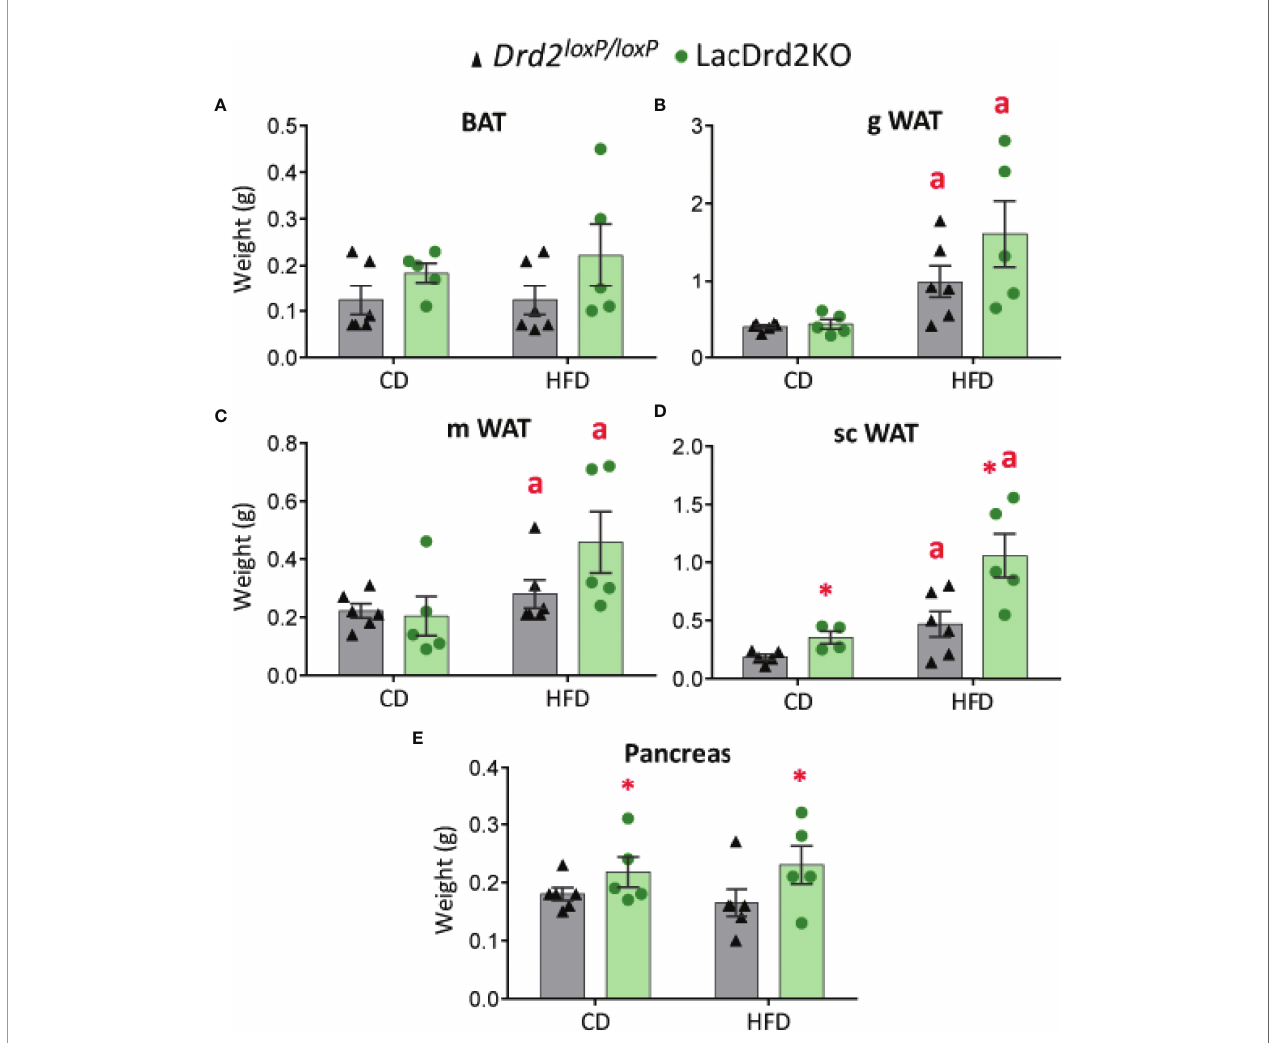
FIGURE 3 | Effect of high-fat diet and hyperprolactinemia on tissue/organ weight. (A) brown adipose tissue (BAT), (B) gonadal white adipose tissue (gWAT), (C) mesenteric white adipose tissue (mWAT), and (D) subcutaneous white adipose tissue (scWAT) weights in g, (E) pancreas in 5-month-old Drd2 loxP/loxP and lacDrd2KO female mice fed a CD or HFD for two months. N (for this fi gure the number of samples is de fi ned from left to right within each panel) = 6, 5, 6, 5 (A – C, E) ; and 5, 4, 6, 5 (D) . Two-way ANOVA; “ a ” = P ≤ 0. 05 vs. genotype- matched mice fed with control diet; *P ≤ 0.05 vs. diet- matched Drd2 loxP/loxP